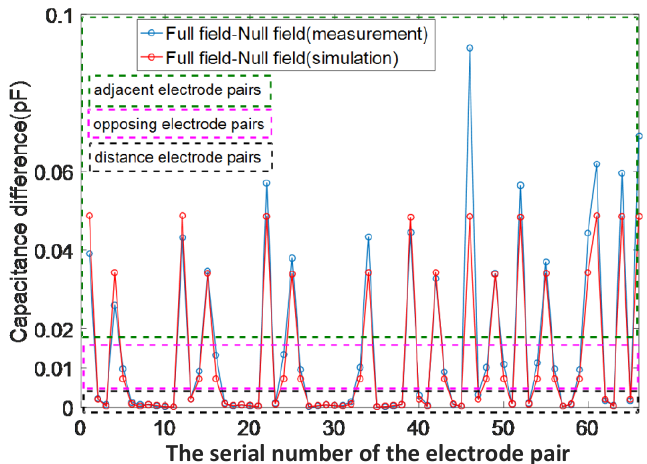
Figure 4. Dynamic range of the capacitance change in total electrodes.